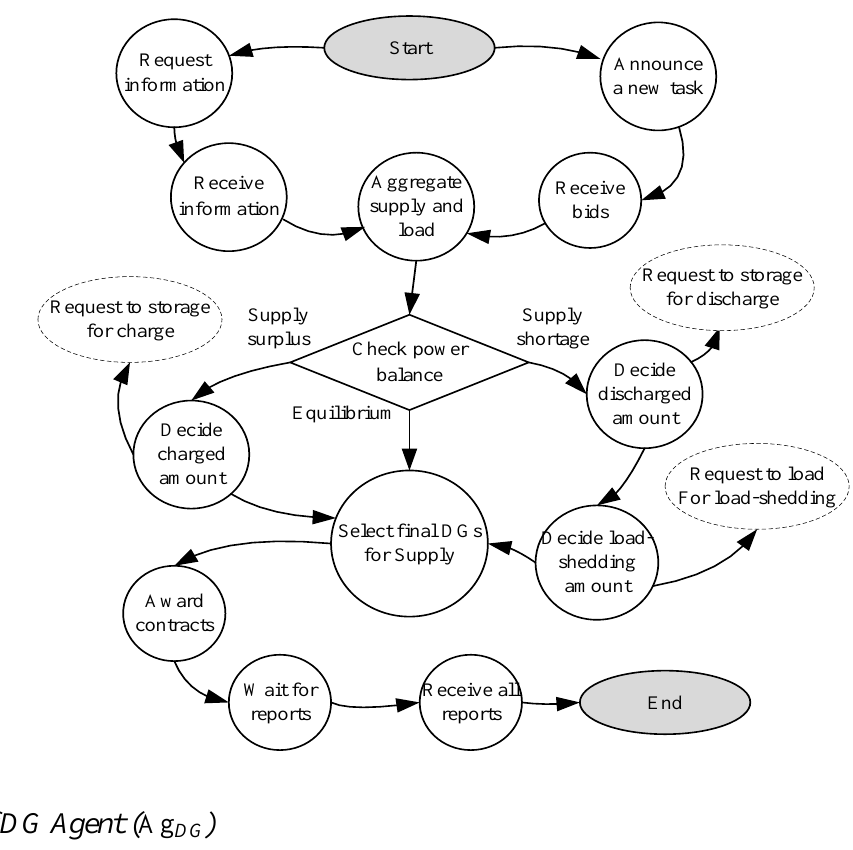
Figure 7. Message flow among